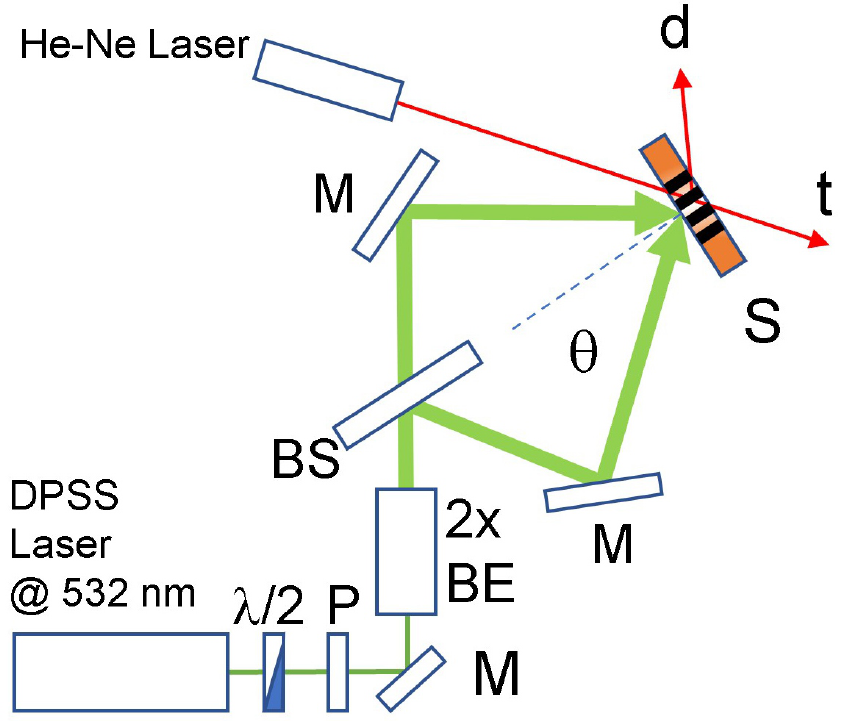
Figure 1. Schematic representation of the writing setup used to record the holographic one di- mensional structures. λ /2 = half wavelength plate; M = mirror; P = polarizer; S = sample; 2 × BE = 2 × beam expander; t and d = transmitted and diffracted beams, respectively. The recorded periodic structure inside the sample is reported in